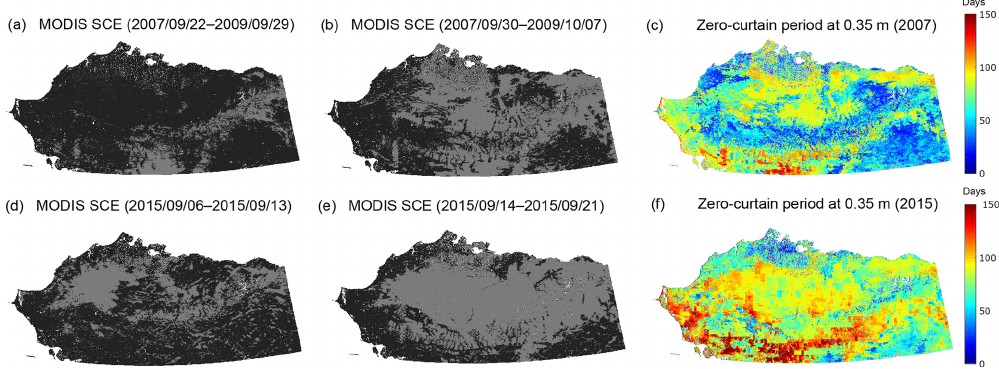
Figure 8. Model-simulated zero-curtain period at 0.35m in relation to snow accumulation during the early snow season indicated by filtered MODIS SCE images for 2 selected years with later (2007: a–c ) and earlier (2015: d–f ) snowfall. In the MODIS images, snow was shown in dark gray, while land was shown in black and the areas masked out were shown in white.